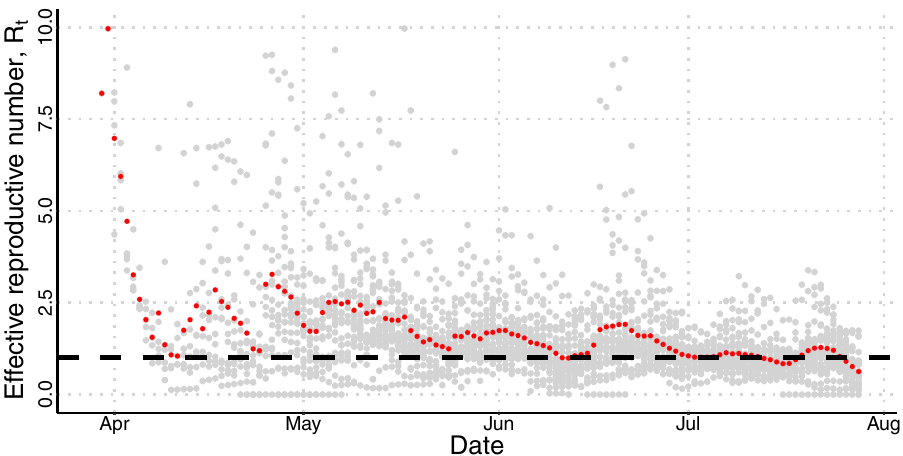
Figure 1. Temporal course of R t in each municipality involved in the study. In red, the average value, and in grey, the individual values. The dashed line shows the threshold of R t = 1 . Above it, the transmission of the disease increases; below it, the disease’s transmission